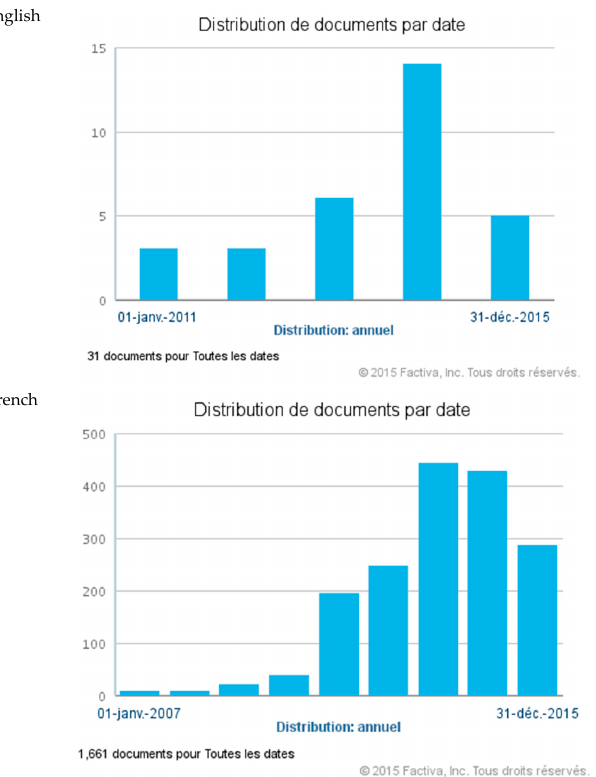
Figure 1. Annual occurrences (2009–2015) of the term ‘shadow banking’ in English and French language sources indexed by the Factiva database 2